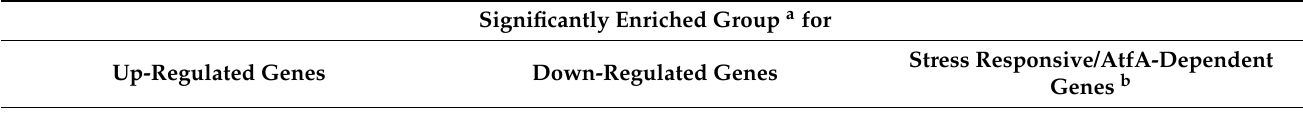
Table 3. Overview on significant enrichment of the studied gene groups.